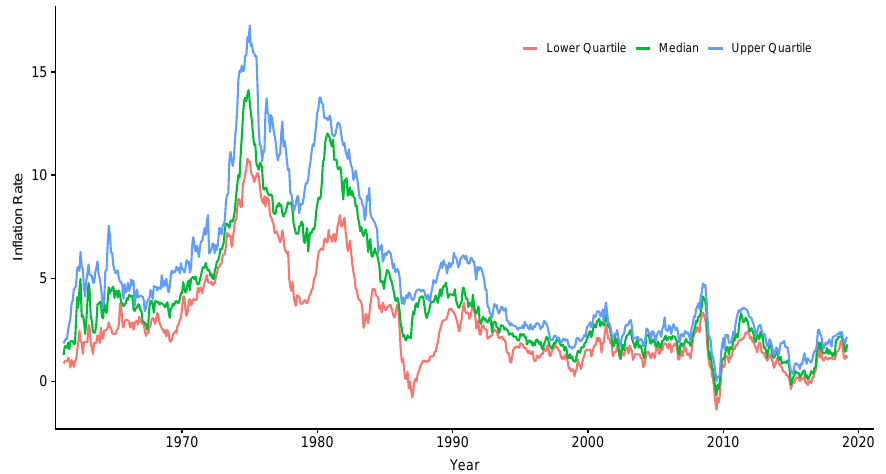
Figure 3. Summary statistics of OECD inflation rates: Inflation rates are computed as year-on-year differences in the logarithm of monthly CPIs. The CPI base year is 2015. Data are obtained from the OECD database. The observation period is April 1961 to March